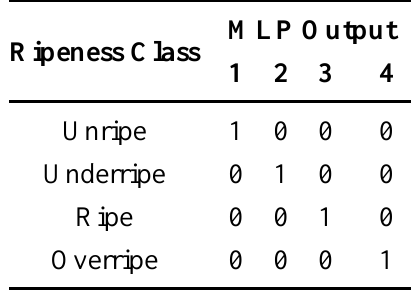
Table 2. Output coding representations for CA and CB combinations.